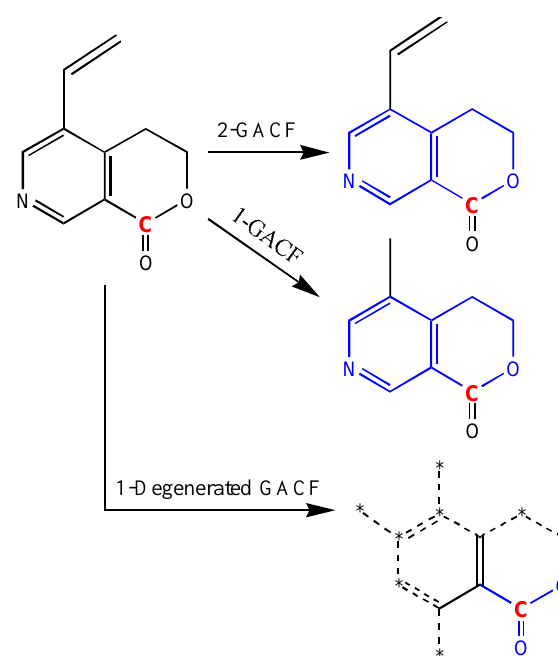
Figure 15. If 1-GACF and 2-GACF are not found in a knowledge base, the 1-Degenerated GACF may have more chance to match with a GACF in the knowledge base to get the closest estimation. “*” represents any atom; dashed bonds represent the bonds not in the Degenerated GACF.